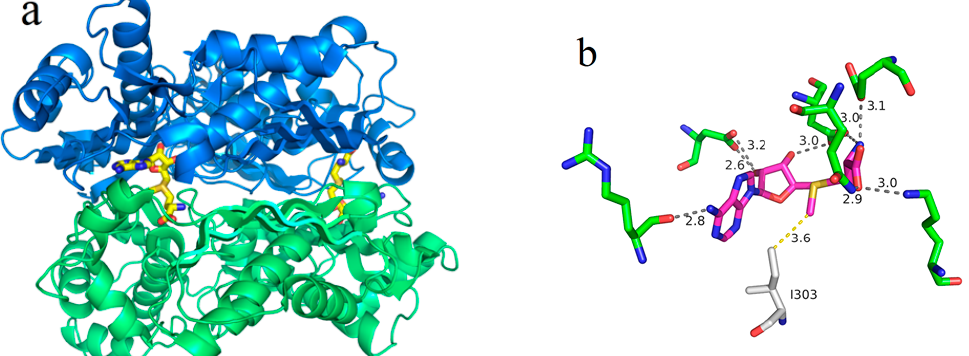
Figure 1. The 3D structure of the methionine adenosyltransferase (MAT) derived from E. coli (PDB: 1RG9). ( a ) The dimeric MAT with S-adenosylmethionine (SAM) bound between two monomer units; ( b ) The binding site of the product SAM (purple carbon atoms) in the active site of MAT. The interaction between the methyl group of SAM and the isoleucine I303 was hypothesized to affect the dissociation of SAM in the active center of the enzyme. Thus, isoleucine I303 became the target of site-directed mutagenesis.